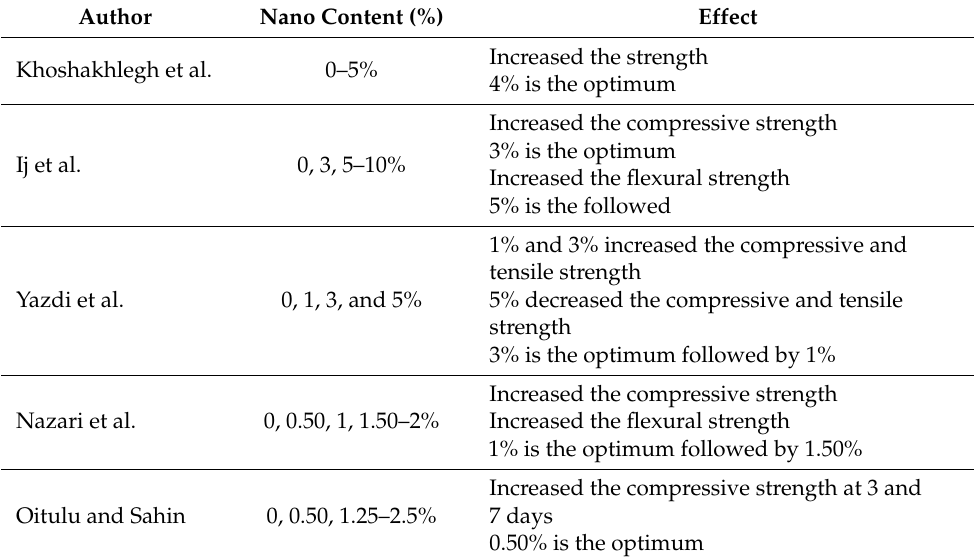
Table 3. Improvements of concrete with addition of nanoparticles. Source: Own